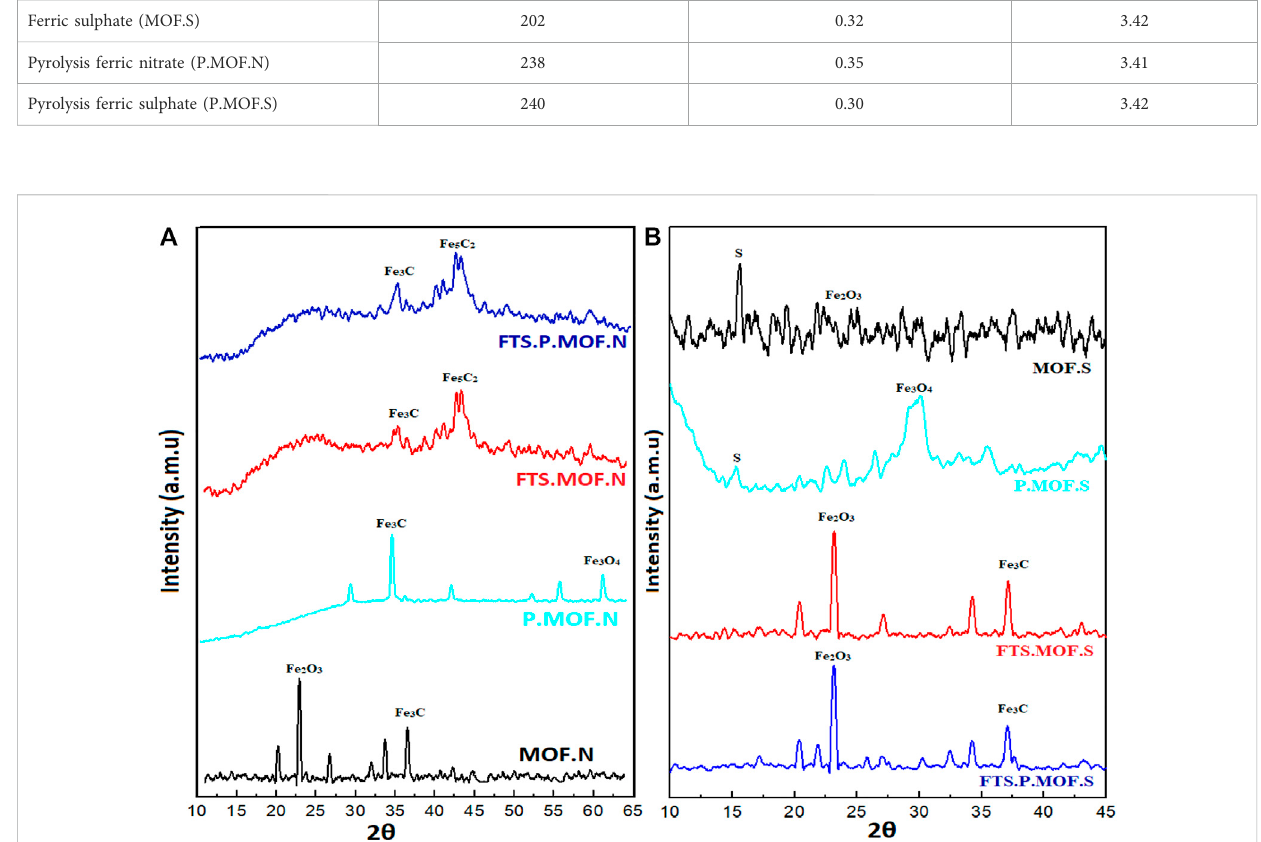
FIGURE 4 XRD analysis of (A) ferric nitrate and (B) ferric sulphate prepared MOF, pyrolysis MOFs and FTS